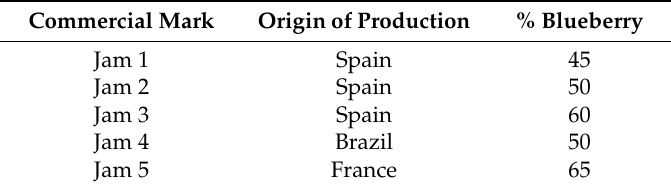
Table 1. Commercial samples acquired to corroborate the validity of the optimized extraction methods. Commercial